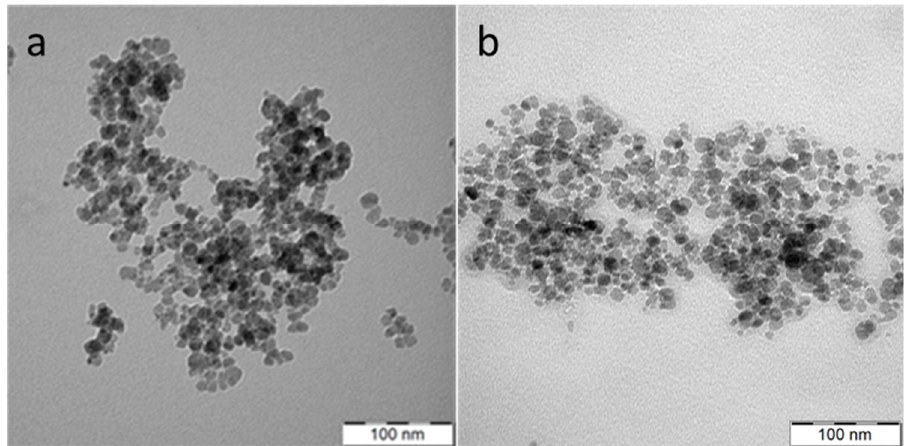
Figure 3. Transmission electron microscope micrographs of ( a ) Fe 3 O 4 and ( b ) Fe 3 O 4 @PEG-Ale nanoparticles. Fe 3 O 4 @PEG-Ale nanoparticles (Figure 1b) exhibited the same D n and size distribution (Figure 3b) as original Fe 3 O 4 particles and slightly increased D h 110 nm. However, Fe 3 O 4 and Fe 3 O 4 @PEG-Ale particles differed in the ζ -potential, amounting to − 46 and − 28 mV, respectively. Superparamagnetic properties of the pure Fe 3 O 4 nanoparticles were confirmed by measuring of hysteresis loops at 300 and 5 K (Figure 4a). Saturation magnetization at these temperatures was 71 and 81 Am 2 /kg, respectively, which is close to that of the bulk state [30], and coercivity of the Fe 3 O 4 was 30 kA/m at 5 K and it was negligible at room temperature.